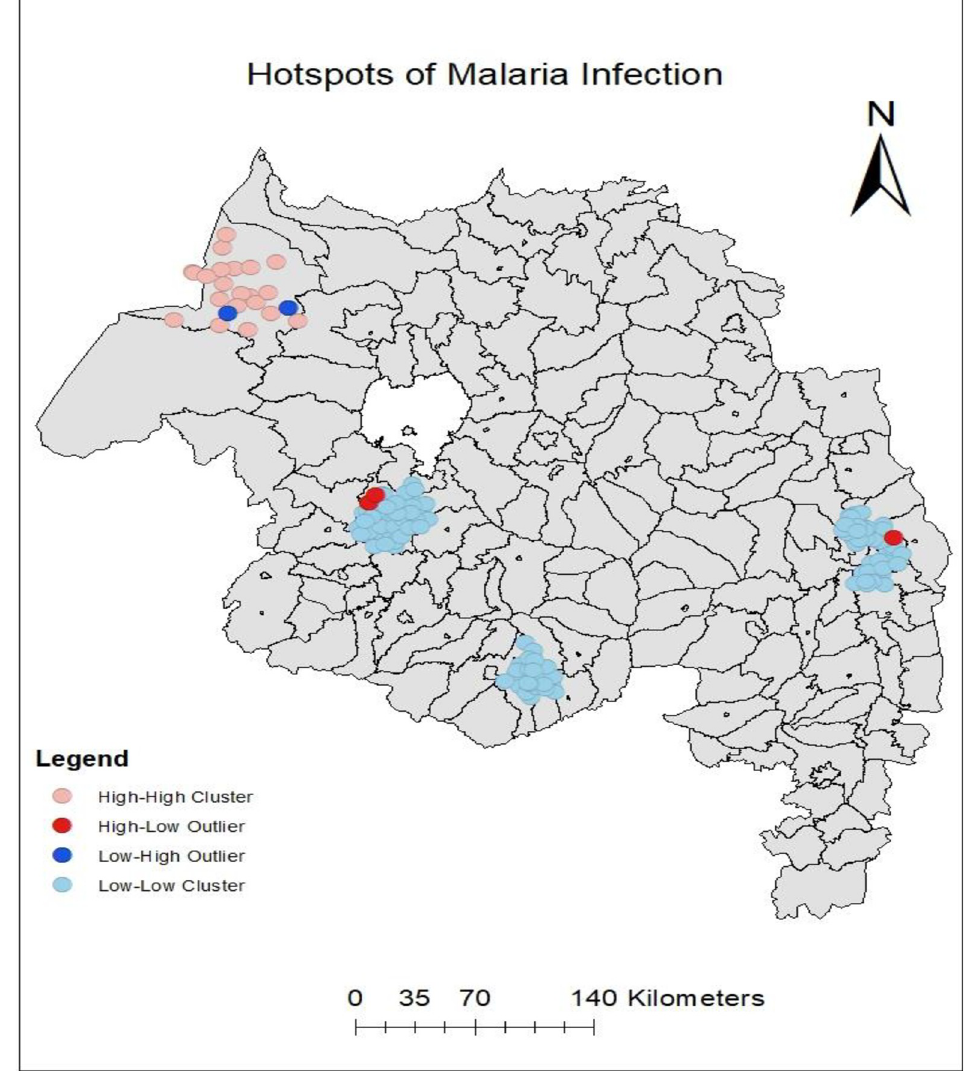
Fig 5. Hotspot clusters of malaria cases in Metema and Gendawuha districts during the study period. Copyright: © 2022 Zeleke et al. The data on the map is derived from CSA, Ethiopia and APHI, Bahir